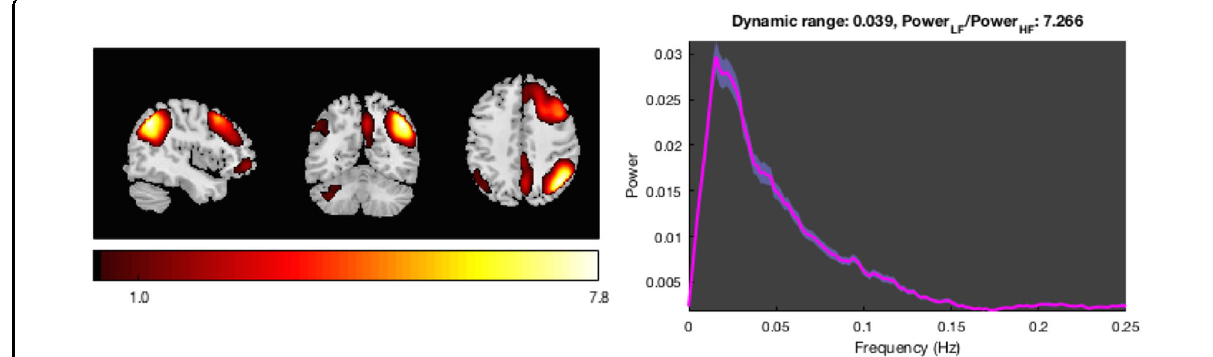
Fig. 4 The fear-dependent modulation of the executive networks IC39 time course was reduced in women at risk for postpartum psychosis (AR) relative to control women. Spatial maps of the independent component loadings are overlaid on the Montreal Neurological Institute brain template. Average power spectrum for each frequency (Hz) is measured in arbitrary units (a.u.).